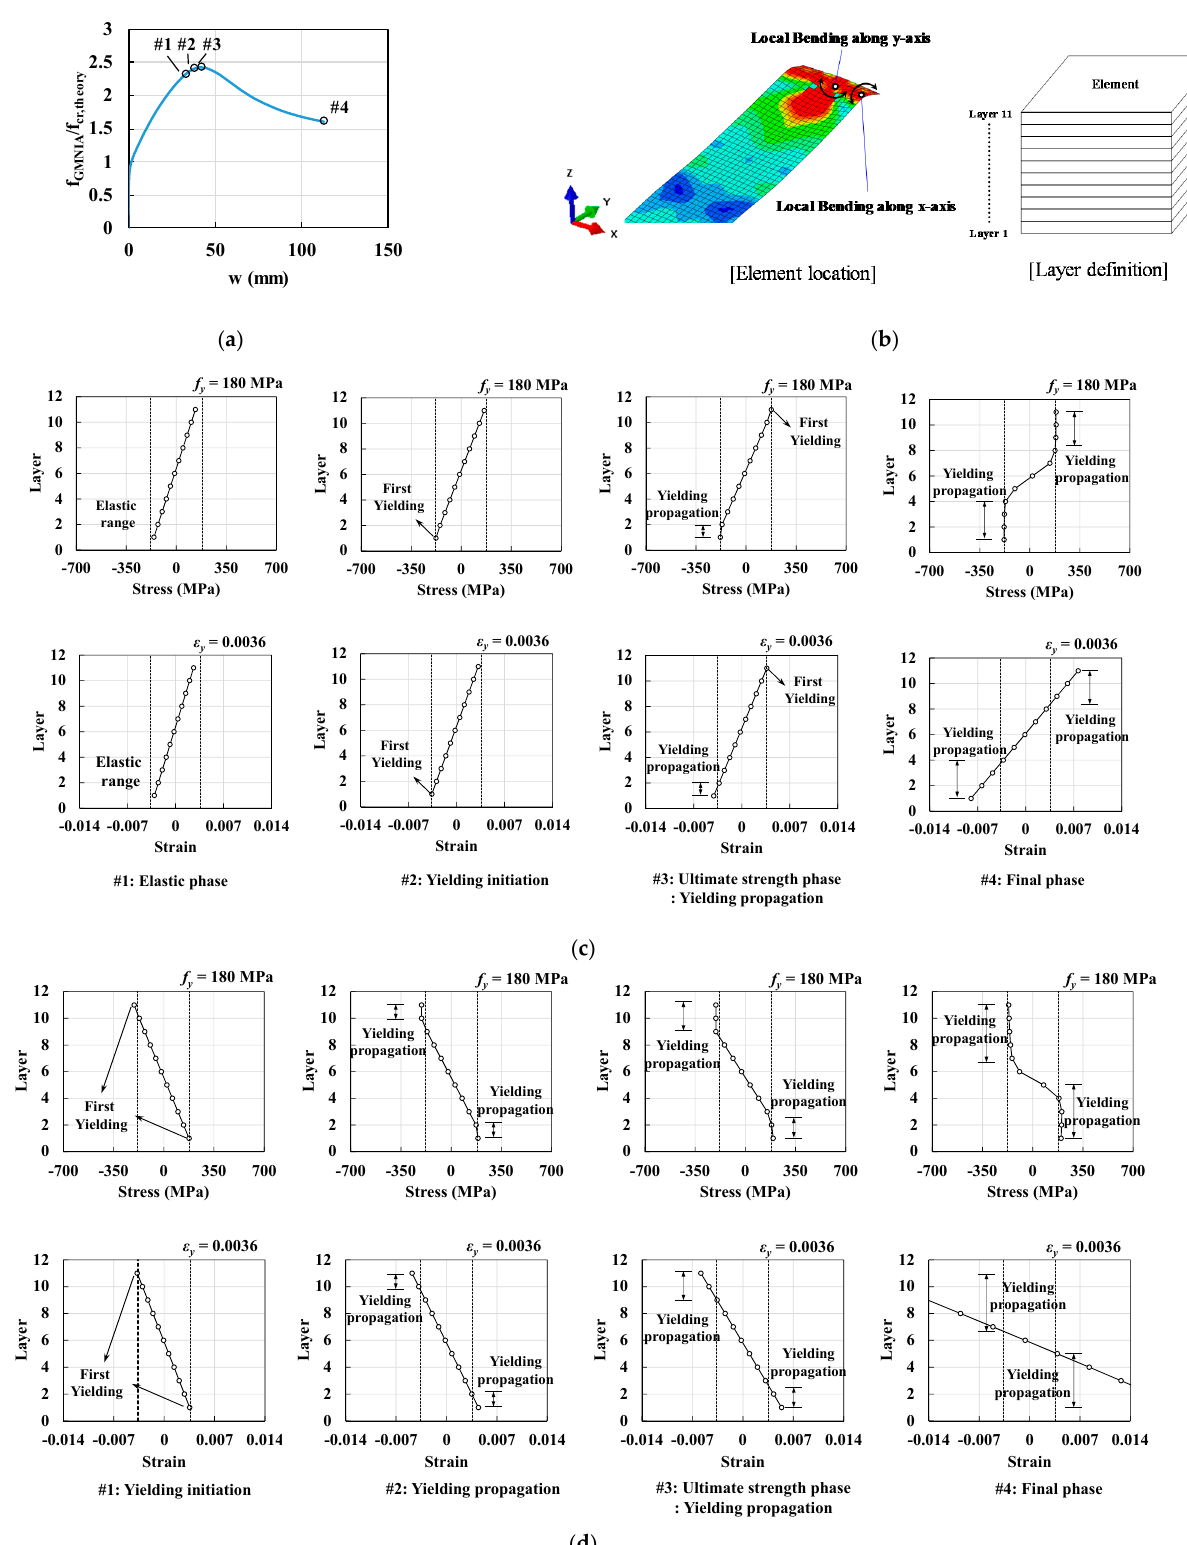
Figure 21. Comparisons of compressive stress and strain for UHPC flanges, modeled using the CDP material model, ac- cording to loading phases: ( a ) definition of loading sequence, ( b ) definition of local bending location and element layers, ( c ) normal stress distribution of local bending along the X -axis, and ( d ) normal stress distribution of local bending along the Y -axis.